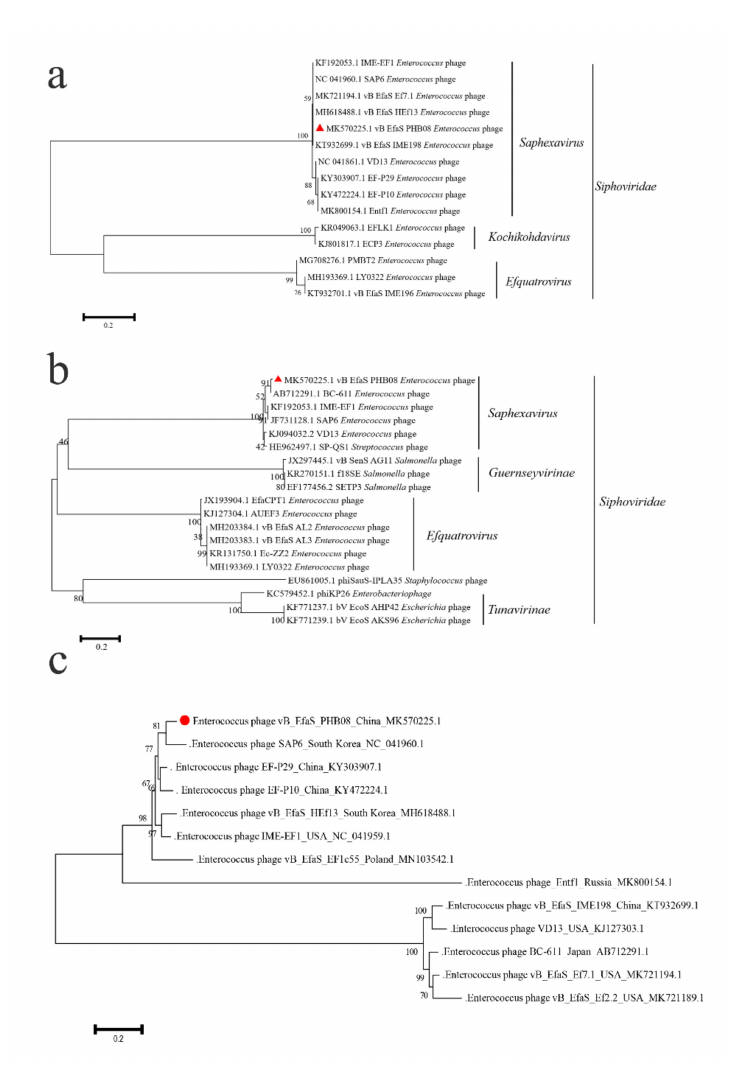
Figure 3. Cluster analysis of phage PHB08. ( a ) The amino acid of terminase large subunit and the major capsid proteins ( b ) of phage PHB08 was analyzed by MEGA X. ( c ) Cluster analysis of Enterococcus